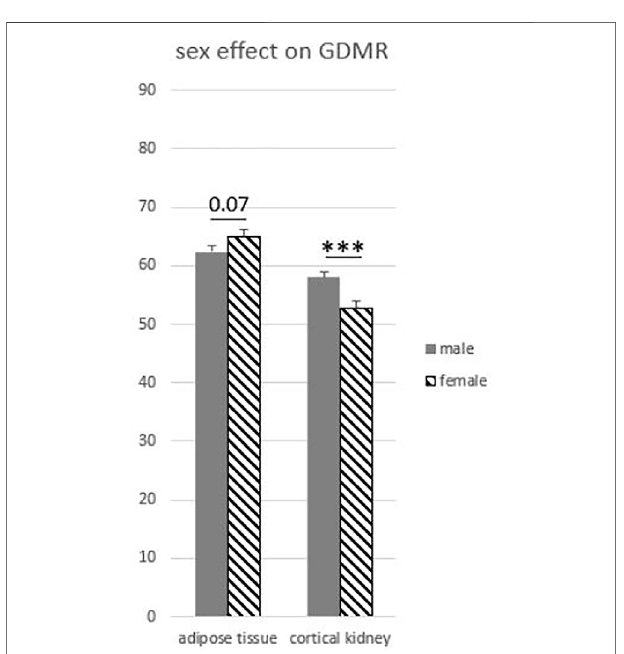
FIGURE 3 | Global DNA methylation rate in fl uenced by sex in adipose and kidney tissues. Model 3 was used for statistical analysis. ppp p <